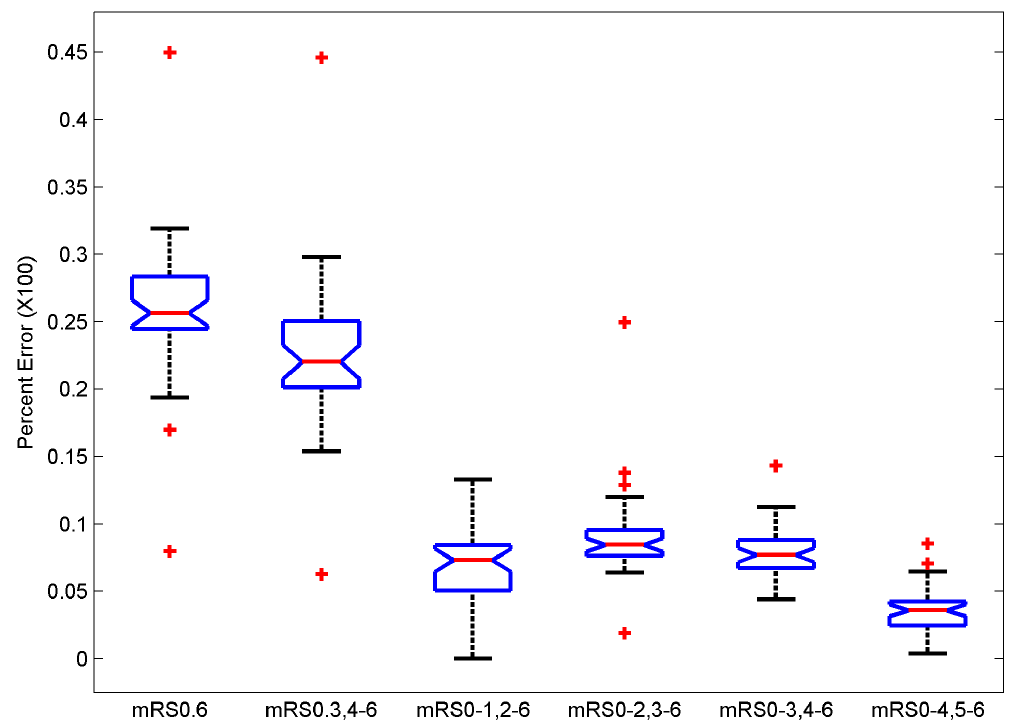
Figure 2. Box plots of error rates for the full ordinal scale of mRS (mRS 0.6), considering mRS 0 to 3 as individual grades and collapsing mRS grades 4 to 6 (mRS 0.3,4–6), dichotomizing at various cut-points of mRS 1 (mRS 0–1, 2–6), mRS 2 (mRS 0–2, 3–6), mRS 3 (mRS 0–3, 4–6) and mRS 4 (mRS 0–4, 5–6). van Swieten’s inter-rater reliability matrix used as confusion matrix. (p , .001 ANOVA; post-hoc testing shows that all dichotomization errors are lower than either full scale errors with mRS 0–4 dichotomization the lowest; p ,